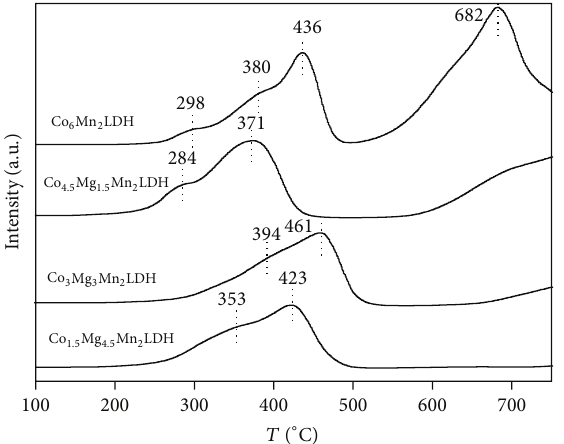
Figure 4: H 2 -TPR patterns of Co 𝑥 Mg 6−𝑥 Mn 2 LDO